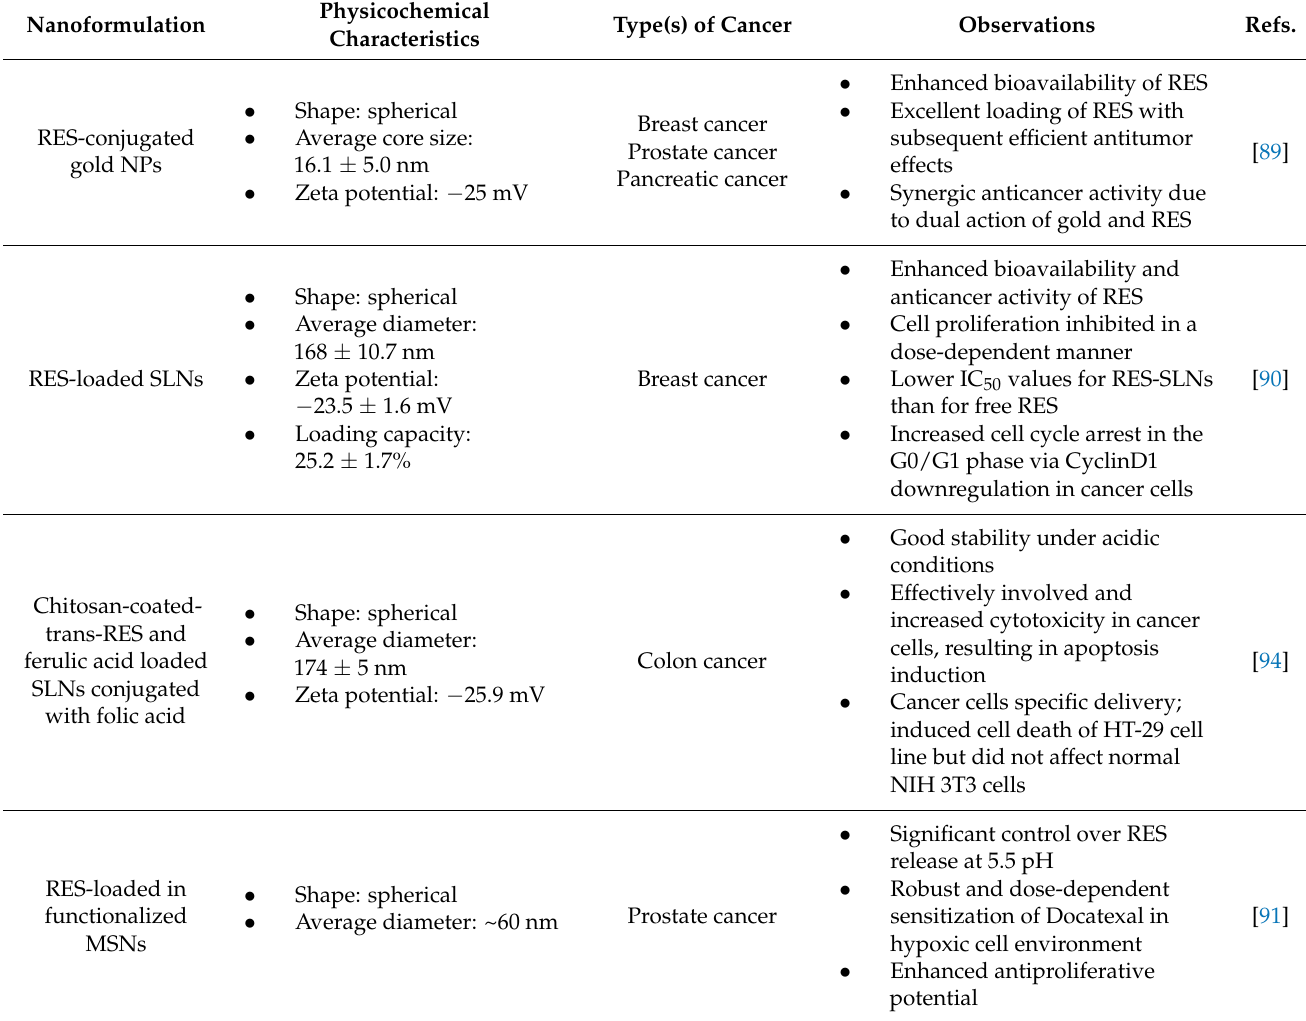
Table 1. Examples of anticancer nanoparticle formulation based on resveratrol. Type(s) of Cancer Observations